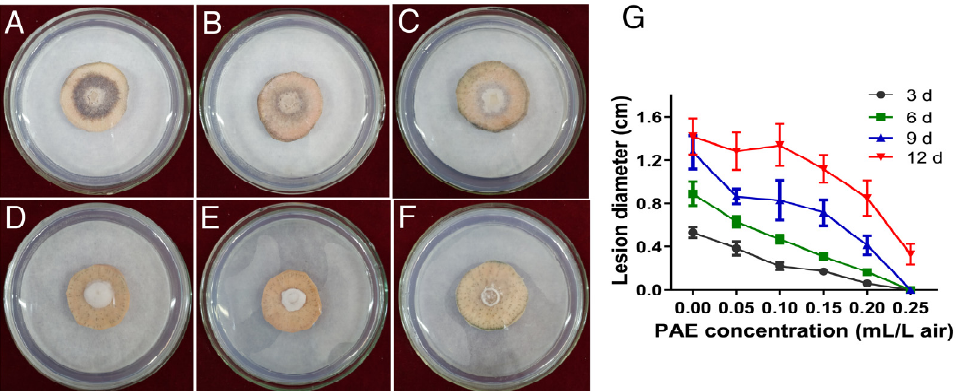
Figure 3. Effect of PAE on sweet potato spoilage caused by F. solani . The sweet potato slices inoculated with mycelial plugs were exposed to different PAE concentrations of 0 ( A ), 0.05 ( B ), 0.10 ( C ), 0.15 ( D ), 0.20 ( E ) and 0.25 ( F ) mL/L air for 12 d at 28 °C. Line chart of lesion diameter on these slices ( G ). Error bars represent the mean standard deviation of four replicates.